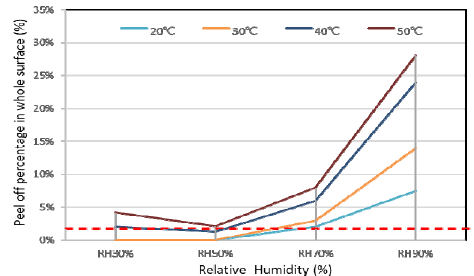
Figure 11. Painting peel percentage in different condition As we know the damp is the key point for physical damage of painting materials, and many recommends keep around 50% ± 5% (ASHRAE 2003), 45% ± 8% and 45% ± 18% (Mecklenburg,